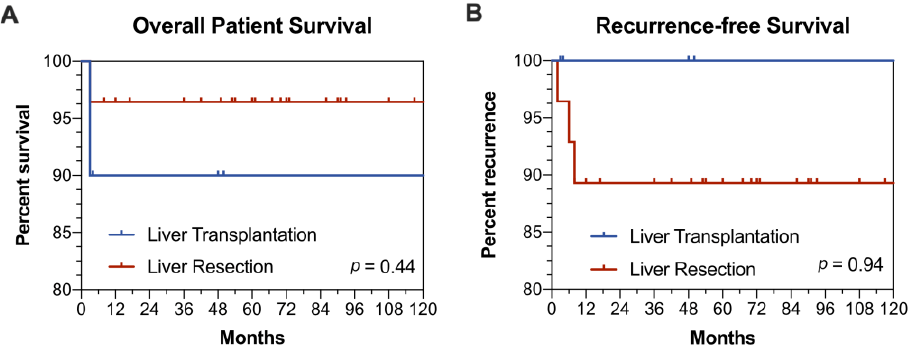
Figure 1. ( A ) Overall patient survival after liver resection or liver transplantation ( B ) Recurrence- free